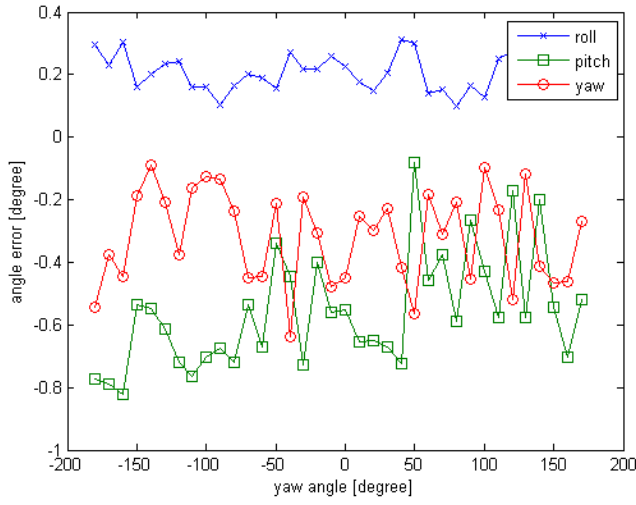
Figure 8. The rotation error curve of Experiment 2 for initial pose.